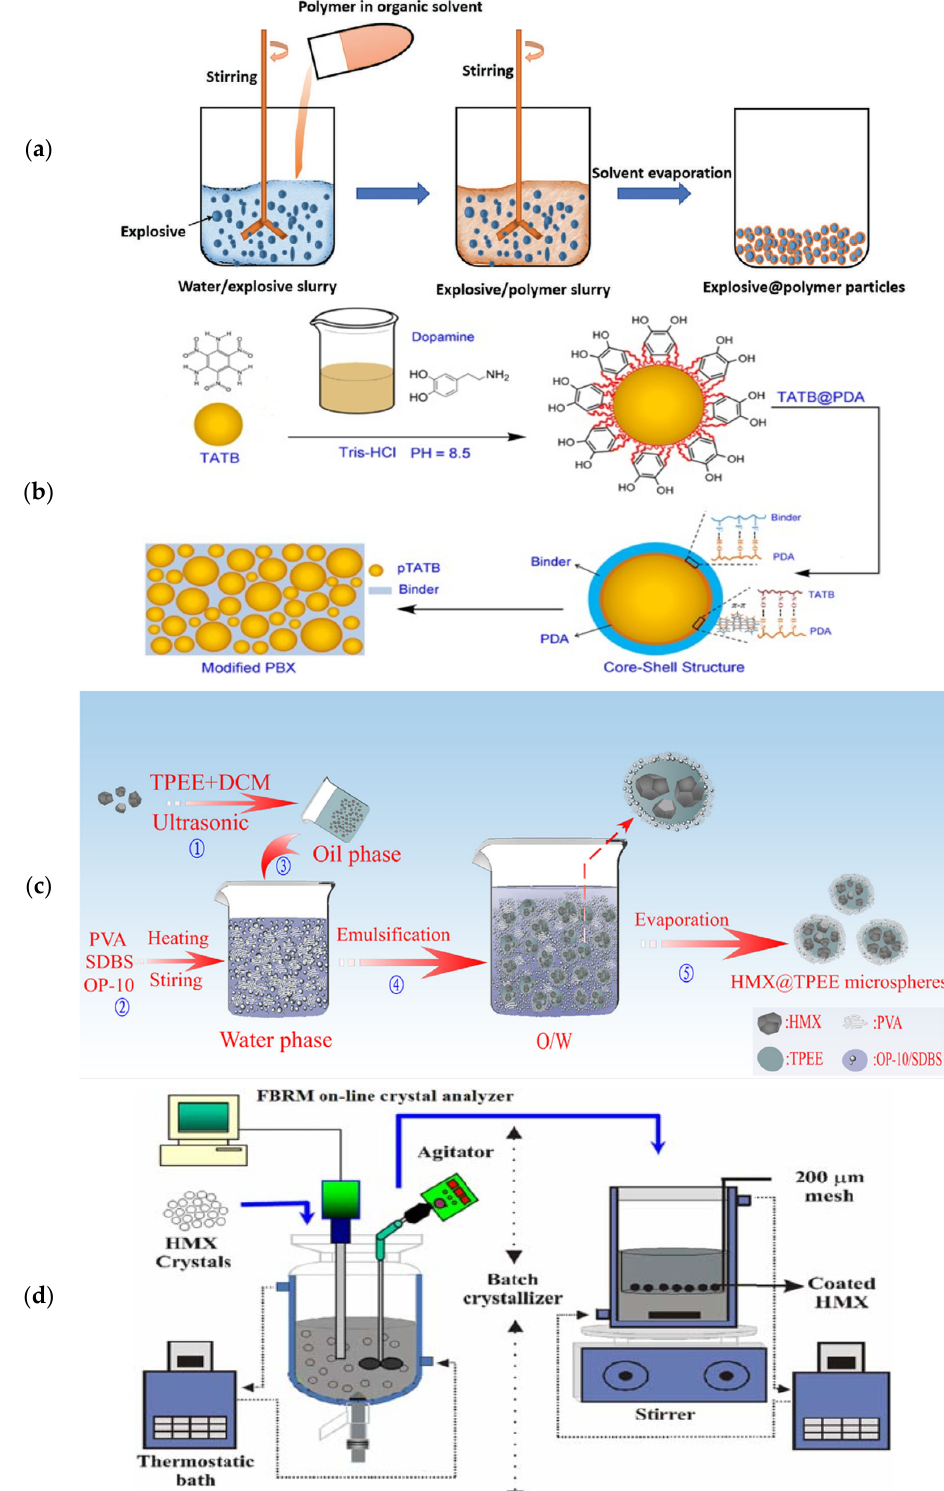
Figure 2. Schematic illustrations of four fabrication methods for CSEs: ( a ) water suspension method; ( b ) in situ polymerization method; ( c ) emulsion technique; ( d ) crystallization coating technique. ( a ) Reproduced with permission from [17], copyright 2020, Wiley-VCH. ( b ) Reproduced with permission from [33], copyright 2017, Royal Society of Chemistry. ( c ) Reproduced with permission from [76], copyright 2017, Elsevier. ( d ) Reproduced with permission from [82], copyright 2007, Wiley-VCH.